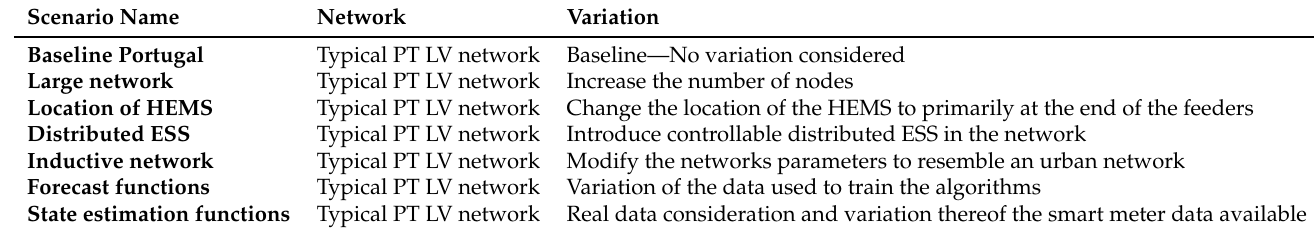
Table 4. Overview of the scenarios for Cluster